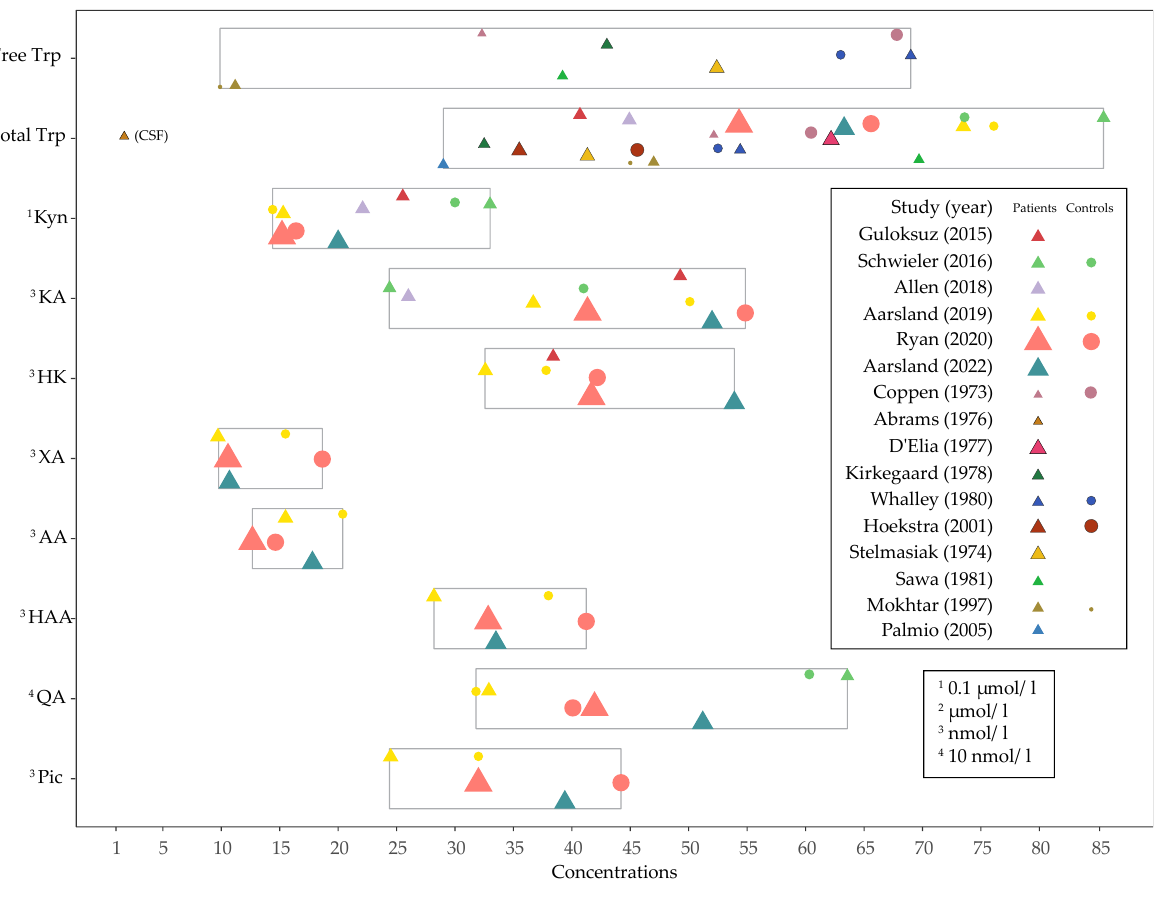
Figure 4. Baseline concentrations of Trp and kynurenines in patients and controls for each study. The size of each symbol represents the number of measured samples. The vertical position of the symbols within each biomarkers box corresponds with the order of the studies in the legend. See Supplementary Table S1 for detailed information on all collected outcome concentrations. Refer-